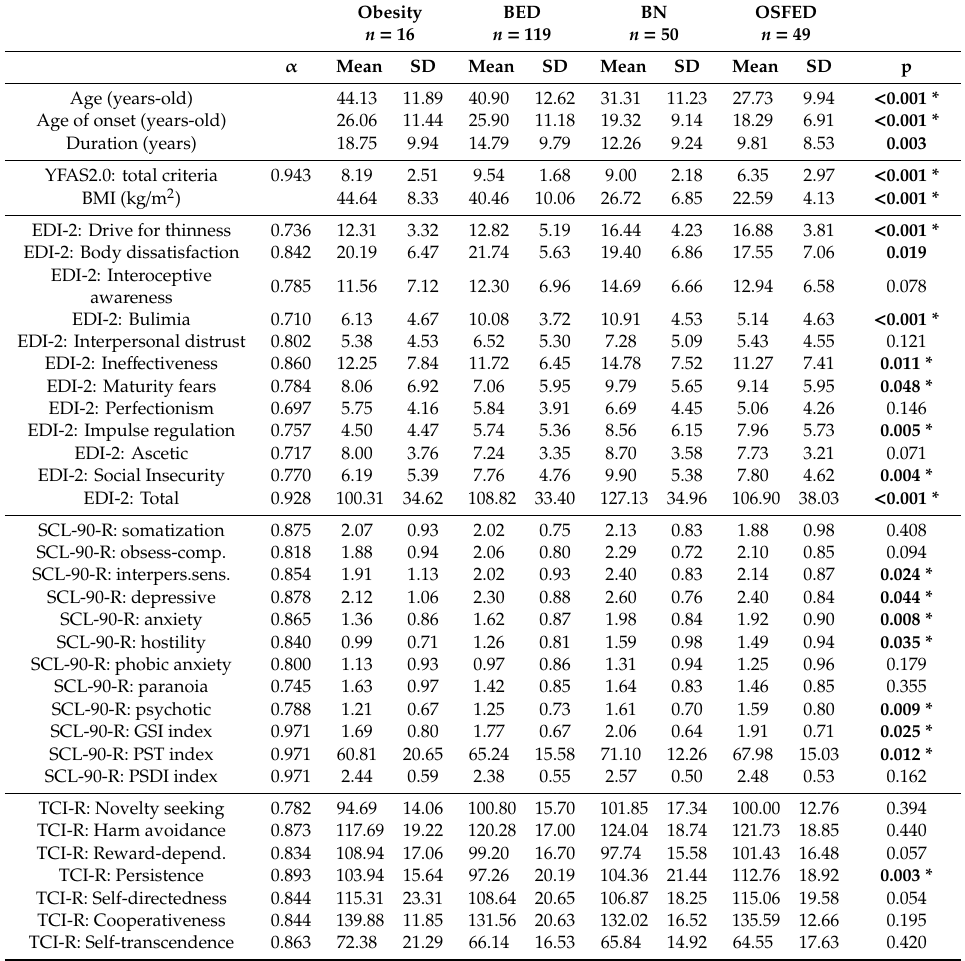
Table A1. Clinical profiles in the